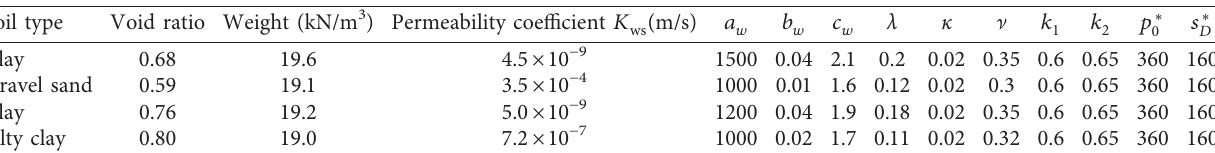
Figure 3: Schematic diagram of the slope calculation Table 1: Soil parameters.